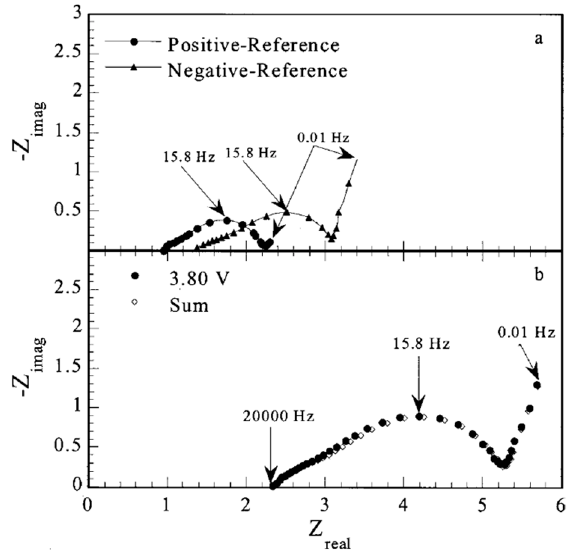
Figure 10. Example of three-electrode EIS measurements for positive and negative electrodes ( a ); comparison between two-electrode measurement and the sum of three-electrode measurements ( b ). Reproduced with permission from [16].